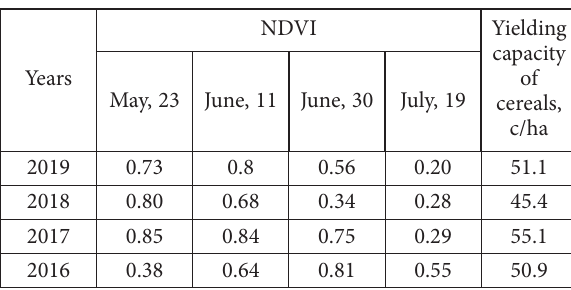
capacity of cereals, c/haMay, 23 June, 11 June, 30 July,